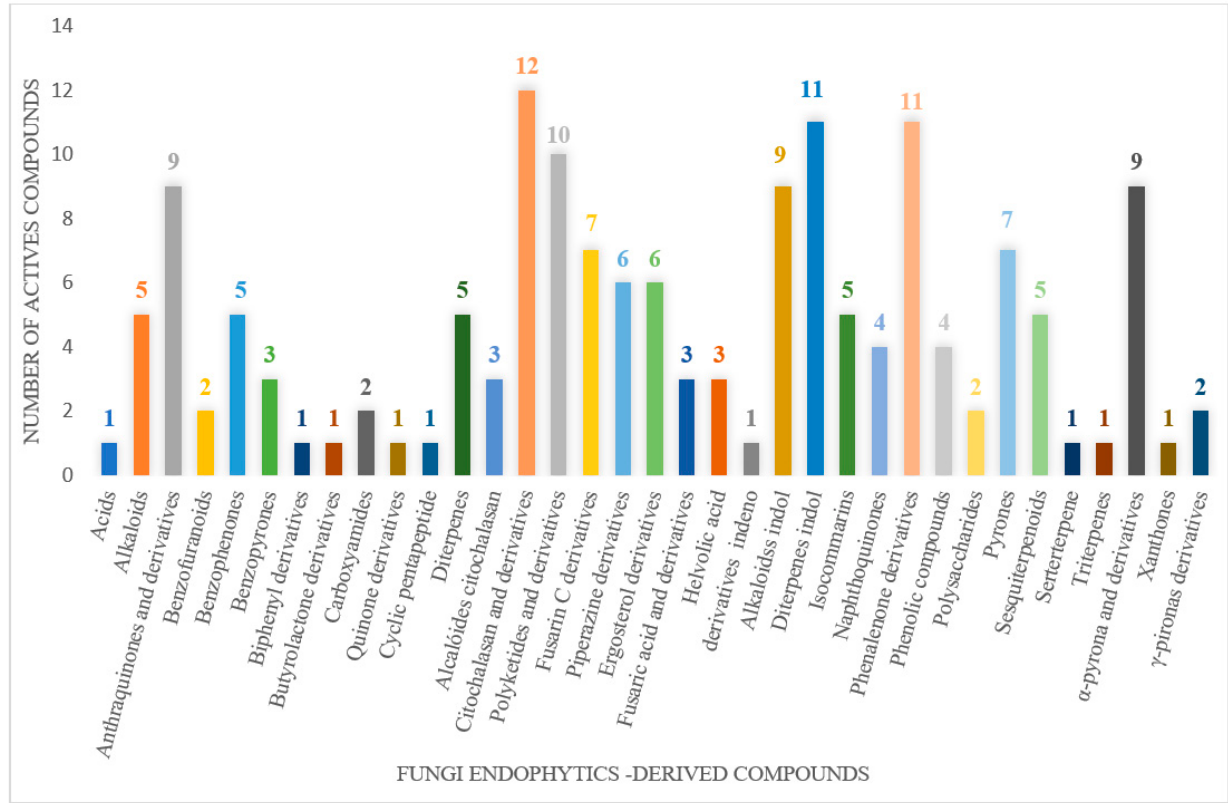
Figure 3. Number of compounds actives derivatives of fungal endophytic contemplated in this review.